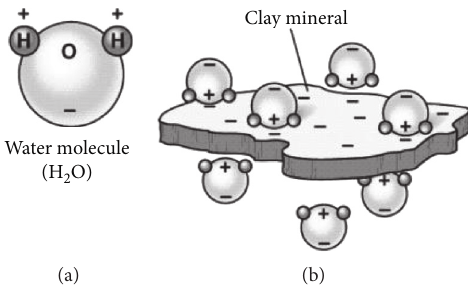
Figure 1: Clay particle and surface charge display